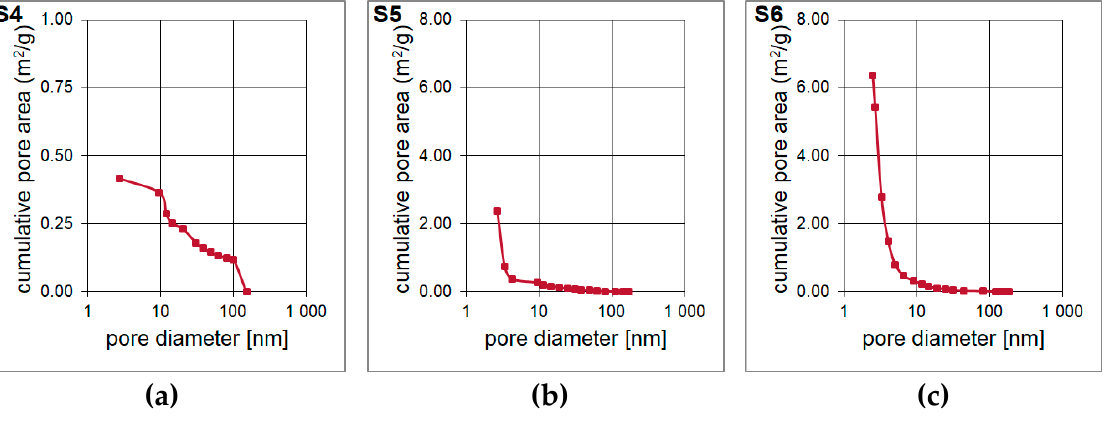
Figure 6. ( a – c ) Pore volume of the porous silicon oxycarbide materials, abbreviation: vol.—volume.